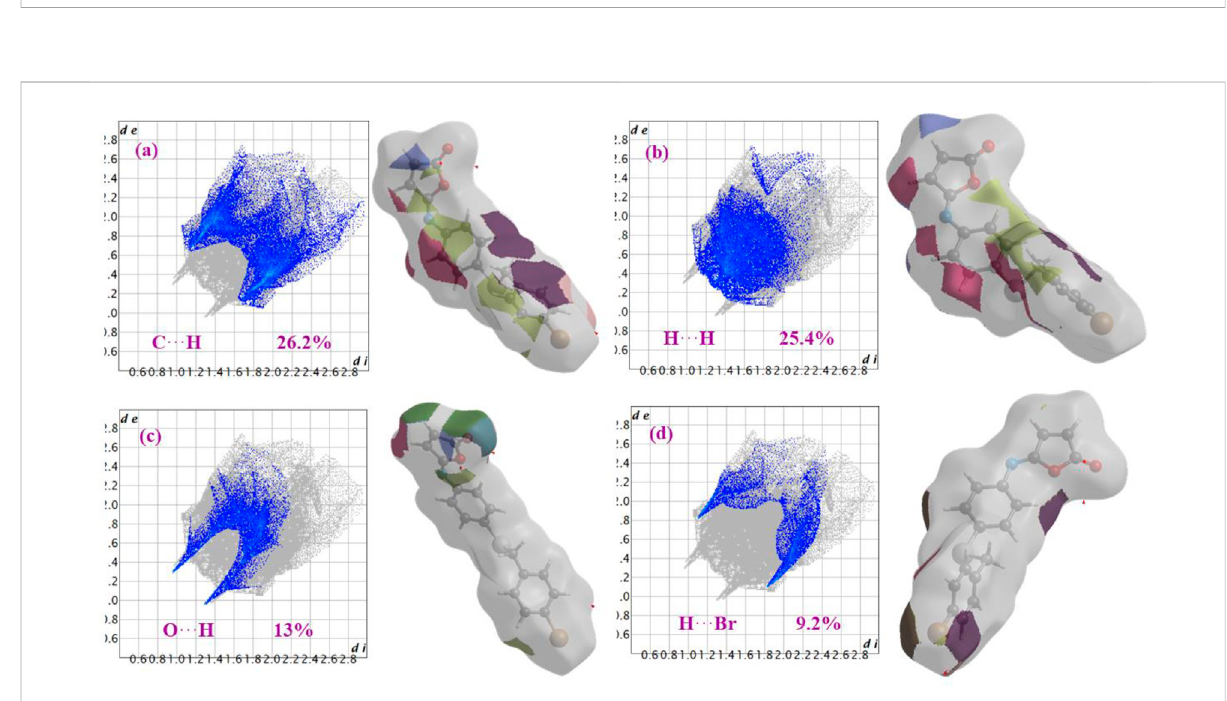
but also investigate other non-covalent interaction types, such as stacking interactions. To visualize this interaction, the H.S. is plotted on a shape index and curvedness. The presence of triangular regions of red and blue around the furan and aromatic rings on the shape index (Figure 5B) and a fl at